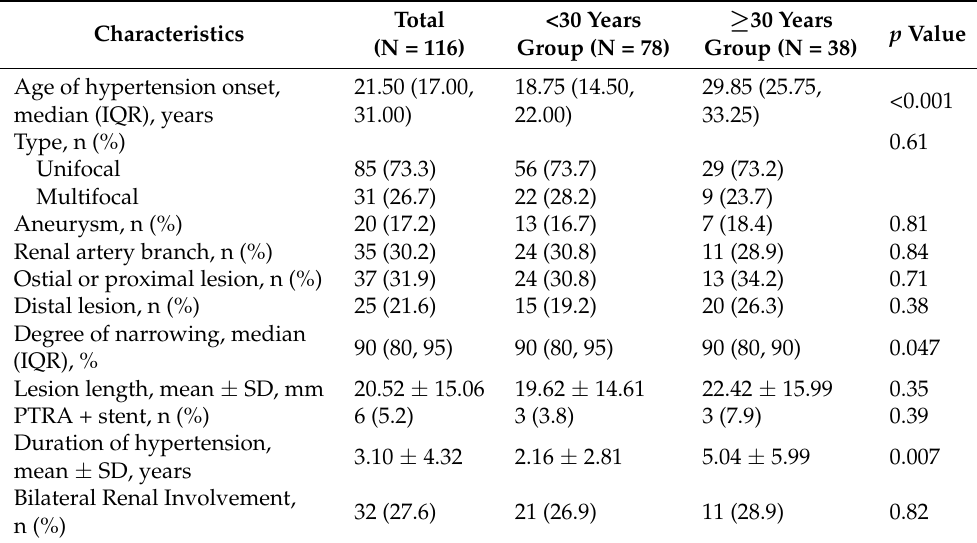
Table 2. Angiographic results of patients with FMD. Characteristics